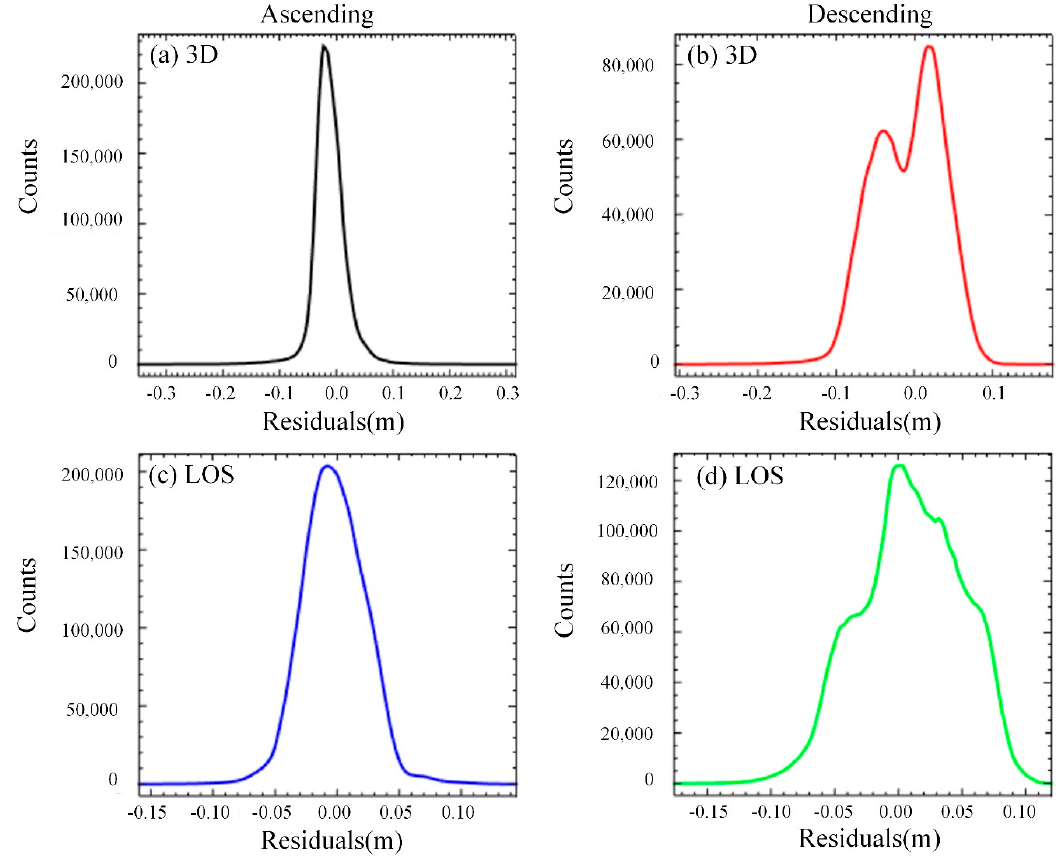
Figure 9. The residual distribution histograms. ( a , b ) correspond the residual in Figure 7c,f, respectively. ( c , d ) correspond the resiudal in Figure 7i,l, respectively.